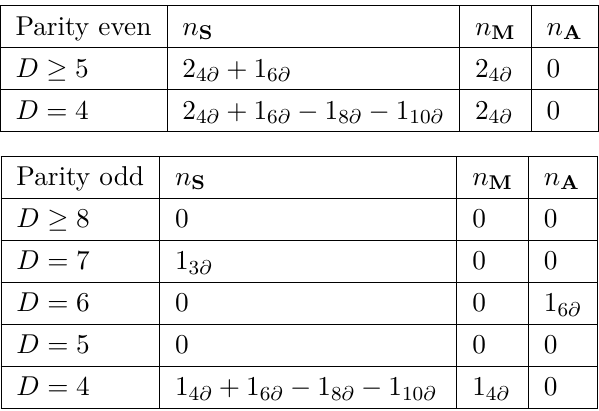
Table 9 . The counting of generators and relations for the quasi-invariant local photon module. The relations are counted with negative sign. The subscript ∂ indicates the derivative order of the